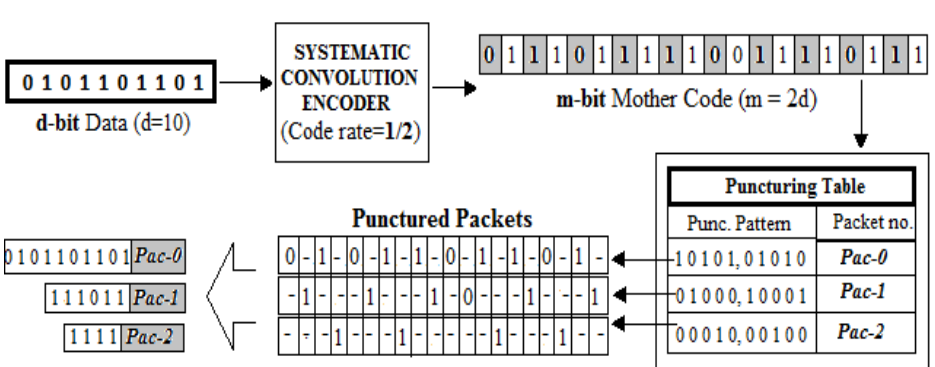
Figure 2. Packet Generation.